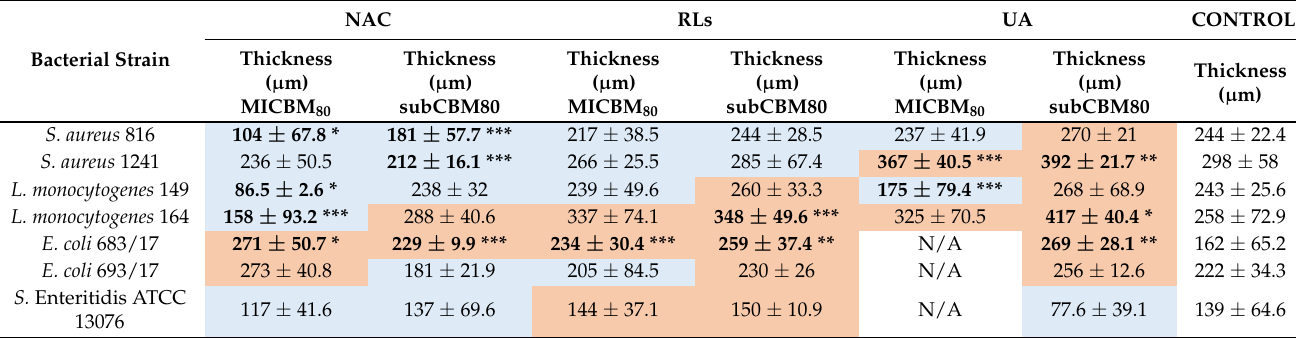
Table 3. Biofilm Prevention: Total biofilm thickness for individual organisms with the respective treatment types ( N -Acetyl- L -cysteine (NAC), rhamnolipids (RLs), and usnic acid (UA)) following 24 h of exposure. Data represent the mean and standard deviation of at least four independent technical